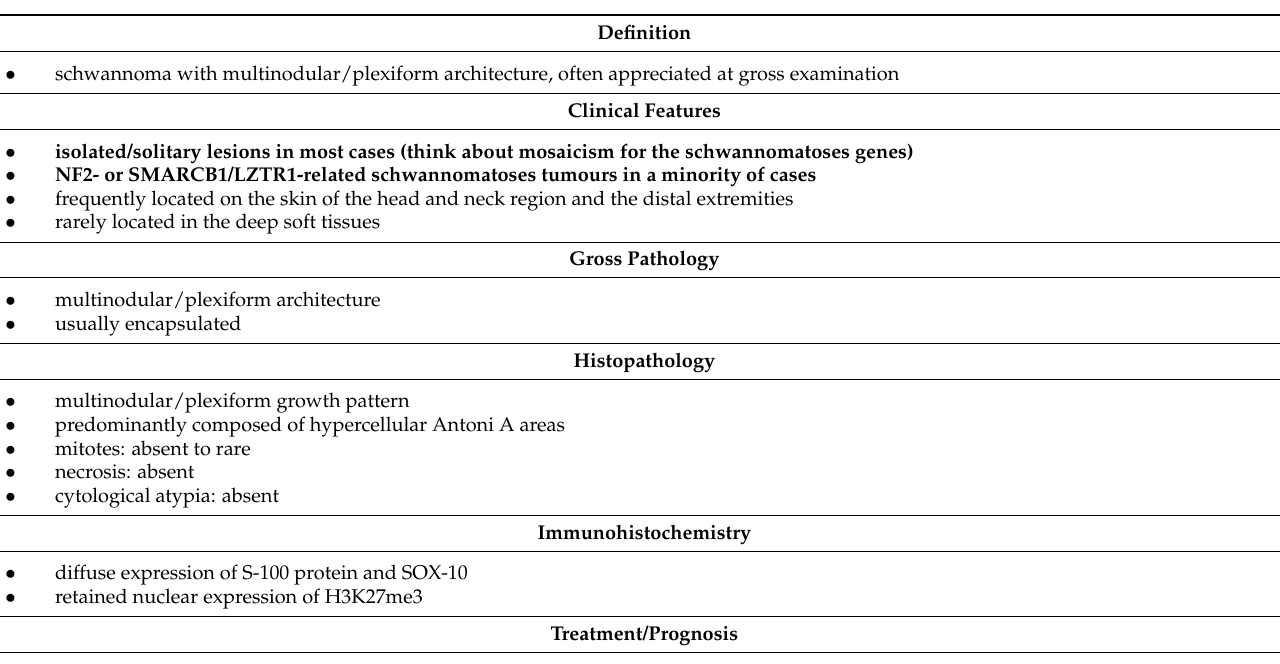
Table 11. Key diagnostic features of plexiform